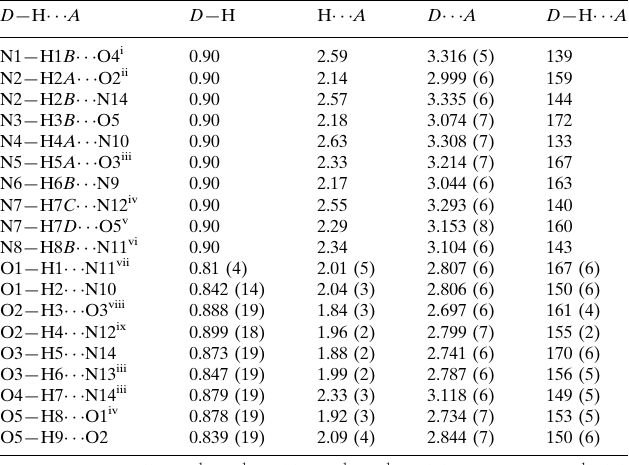
Table 2 Hydrogen-bond geometry (A˚ , (cid:3)